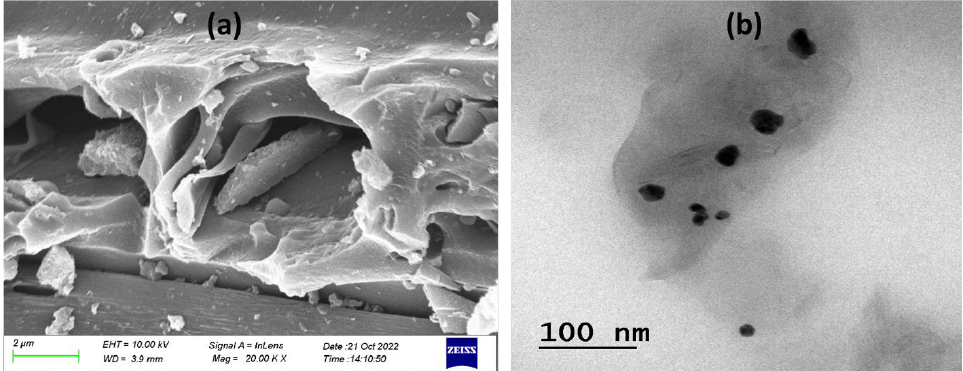
Figure 3. Morphology study ( a ) SEM and TEM ( b ) image of AEOs emulgel. 0.001 wt.% emulgels were dried at 24.5 °C in both cases.